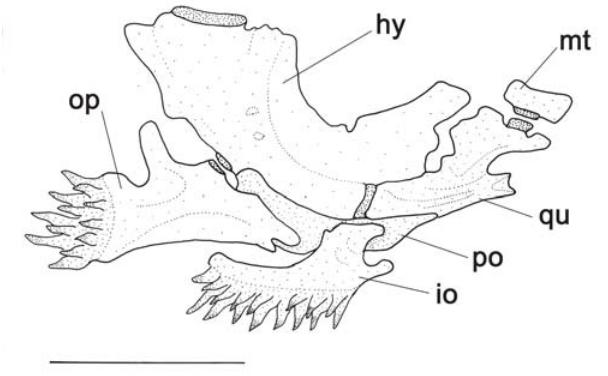
Fig. 4. Left hyoid arch of Ituglanis cahyensis , MNRJ 28405, paratype, 41.3 mm SL. Ventral view. Abbreviations: ac, ante- rior ceratohyal; br, branchiostegal rays; ic, interceratohyal cartilage; pc, posterior ceratohyal; vh, ventral hypohyal; udp, urohyal dorsal process; uls, urohyal laminar surface; ur, urohyal. Scale bar = 1.0